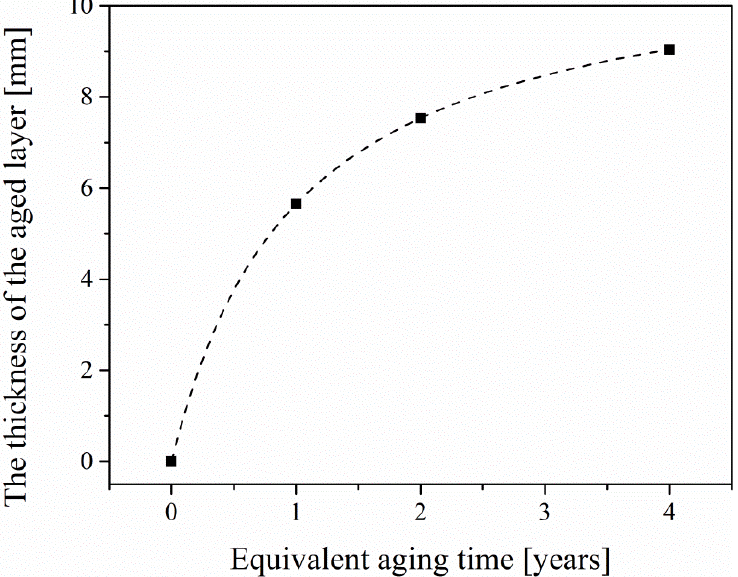
Figure 13. The thickness of the aged layer–equivalent aging time curve.